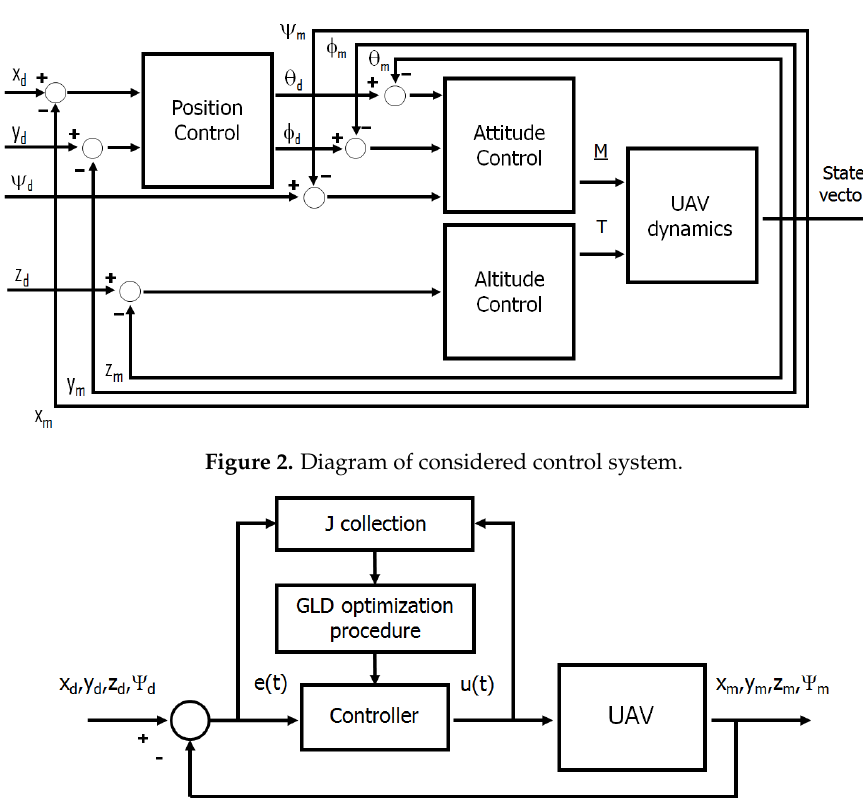
Figure 3. General block diagram of the control system with